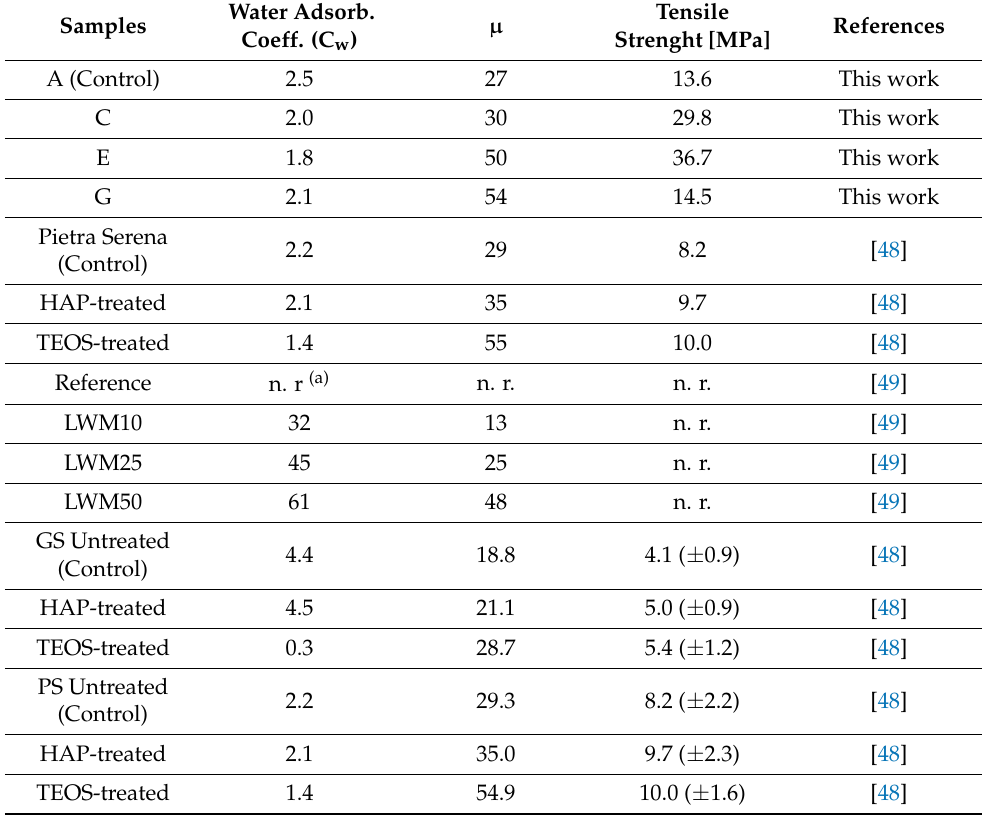
Table 9. Comparative data analysis in terms of water adsorption coefficient, Water Vapour resistance, µ , and tensile strength for different consolidating treatments applied on Florentine Pietraforte